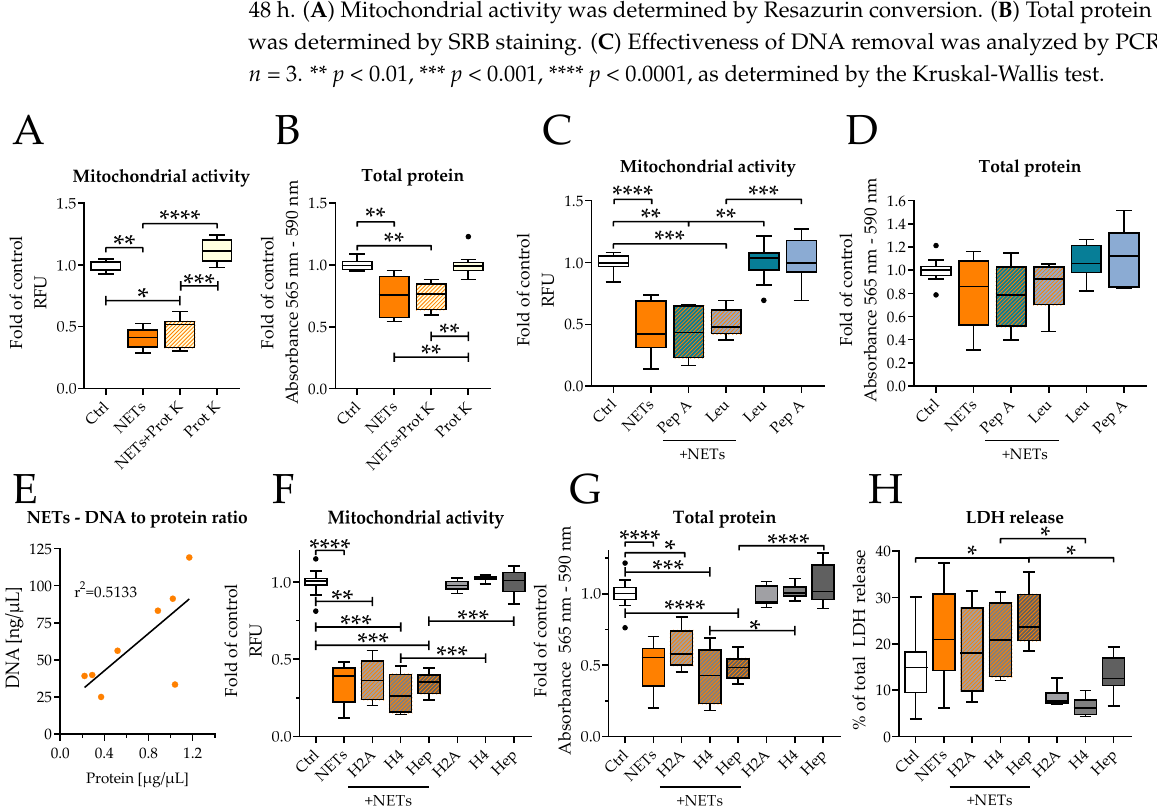
Figure 5. Inhibition of proteases or histones did not prevent NETs toxicity. ( A , B ) SCP-1 cells were incubated with 0.5 ng/ µ L of NETs and 0.5 µ g/mL of Proteinase K. After 48 h, mitochondrial activity ( A ) and total protein content ( B ) were determined. ( C , D ) SCP-1 cells were incubated with 0.5 ng/ µ L of NETs and either 5 µ g/mL of Leupeptin or 1 µ g/mL of Pepstatin A. Mitochondrial activity ( C ) and total protein content ( D ) were determined. ( E ) The DNA content of NETs correlates with the protein content N = 3, n = 3. Effect of histone antibodies or heparin (50 µ g/mL) treatment ( F – H ): ( F ) mitochondrial activity (resazurin conversion) values; ( G ) total protein content (SRB staining); and ( H ) LDH release as indicator for cell death (in relation to lysed cells). N = 2–3, n = 3. * p < 0.05, ** p < 0.01, *** p < 0.001, **** p < 0.0001, as determined by the Kruskal–Wallis